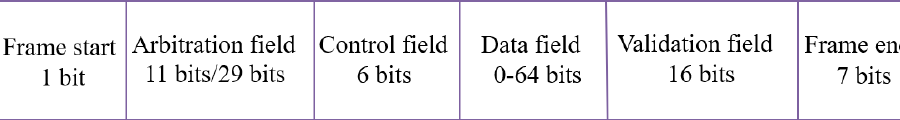
Figure 2. CAN message structure.